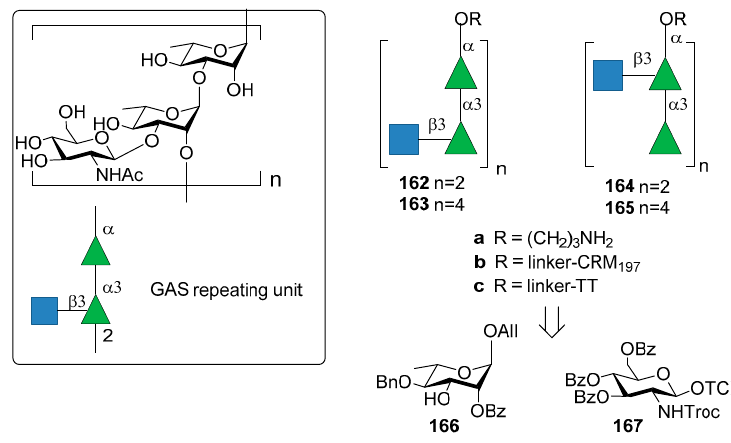
Figure 18. Repeating unit of the cell wall PS of GAS and synthetic fragments reported in [104].